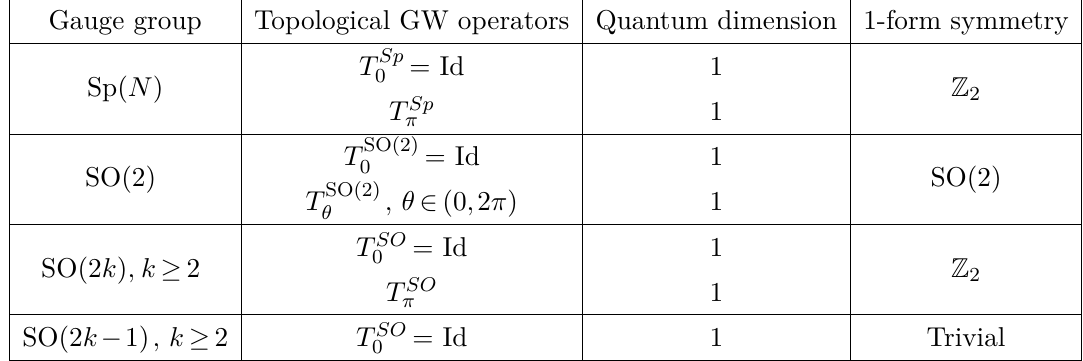
Table 1 . Summary of topological Gukov-Witten operators for theories with Sp( N ) and SO( N ) gauge